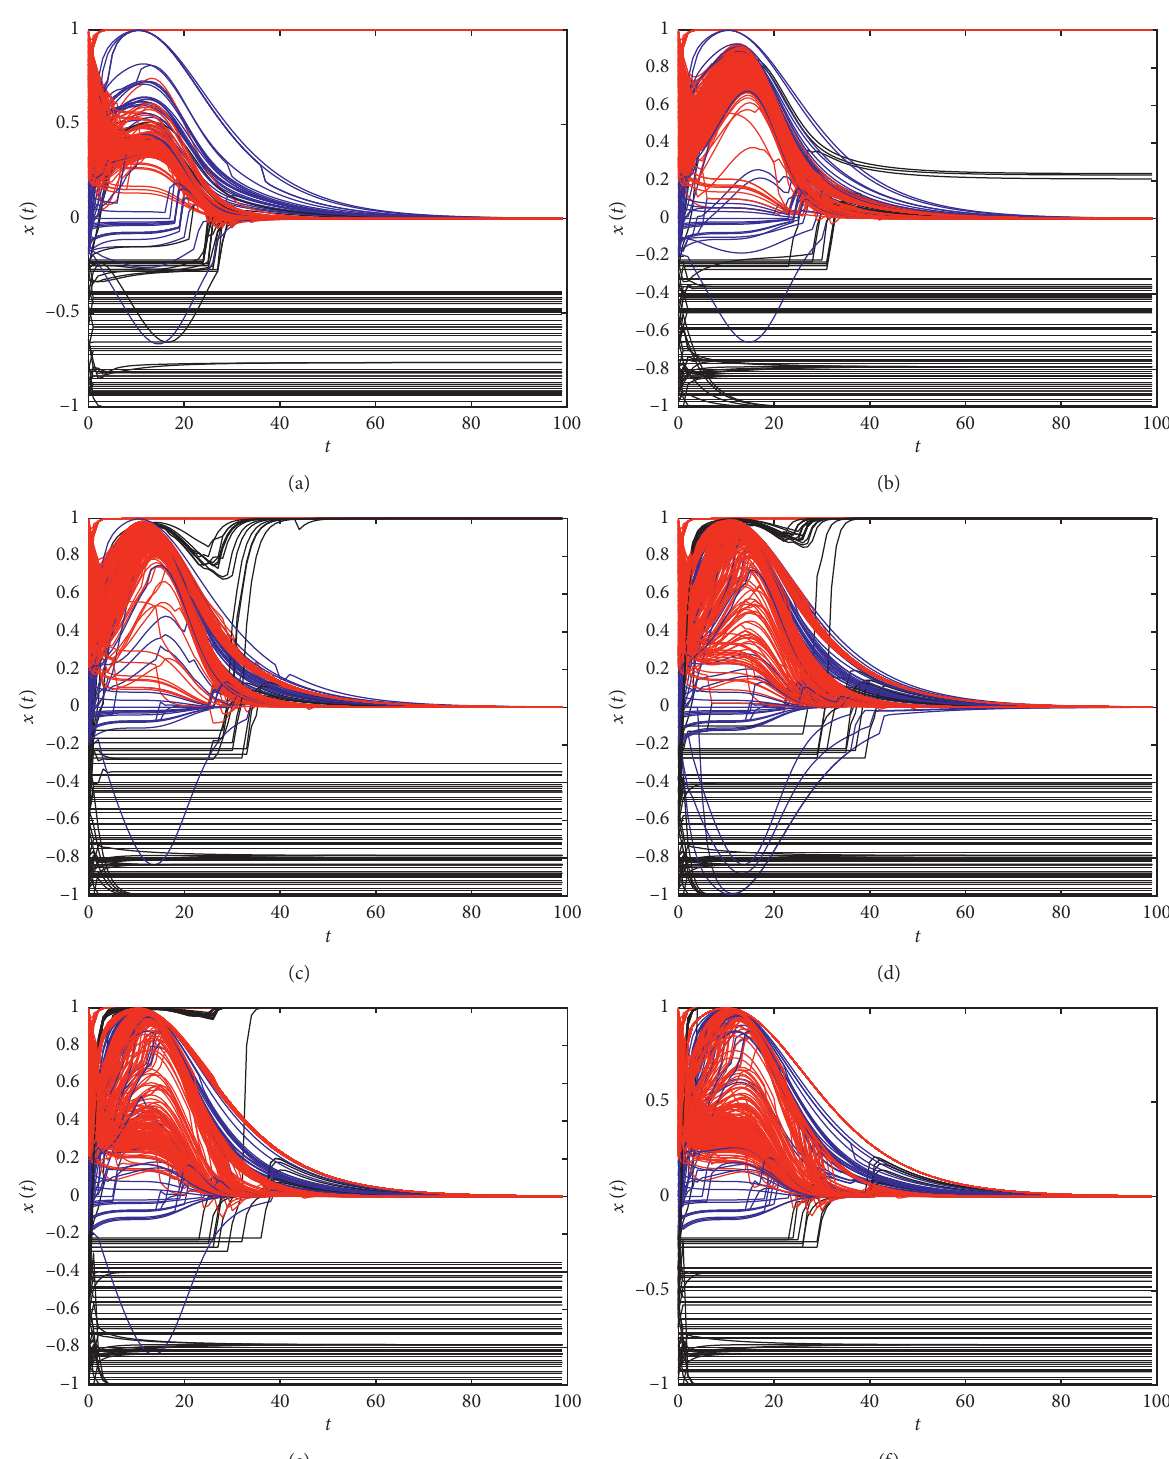
Figure 16: Impact of the influence power of opinion leaders on individual opinion reversal: (a) θ � 0; (b) θ � 0.2; (c) θ � 0.4; (d) θ � 0.6; (e) θ � 0.8; (f) θ �